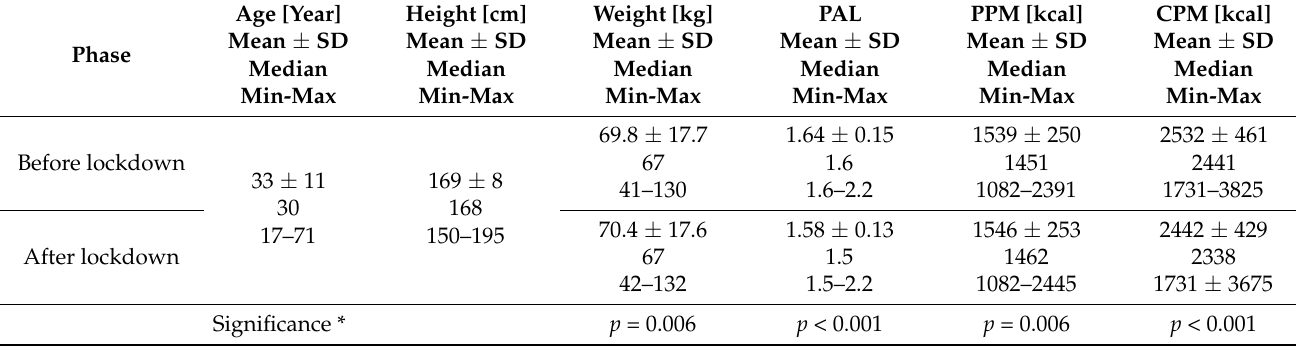
Table 1. Changes in body mass and energy needs in the study group during the lockdown ( n = 183).